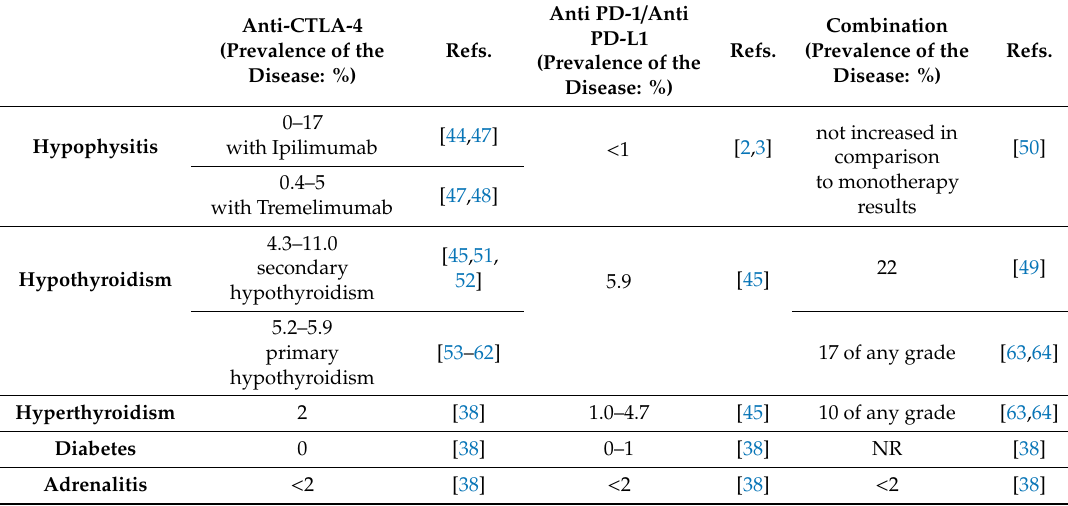
Table 2. Immune–related endocrine